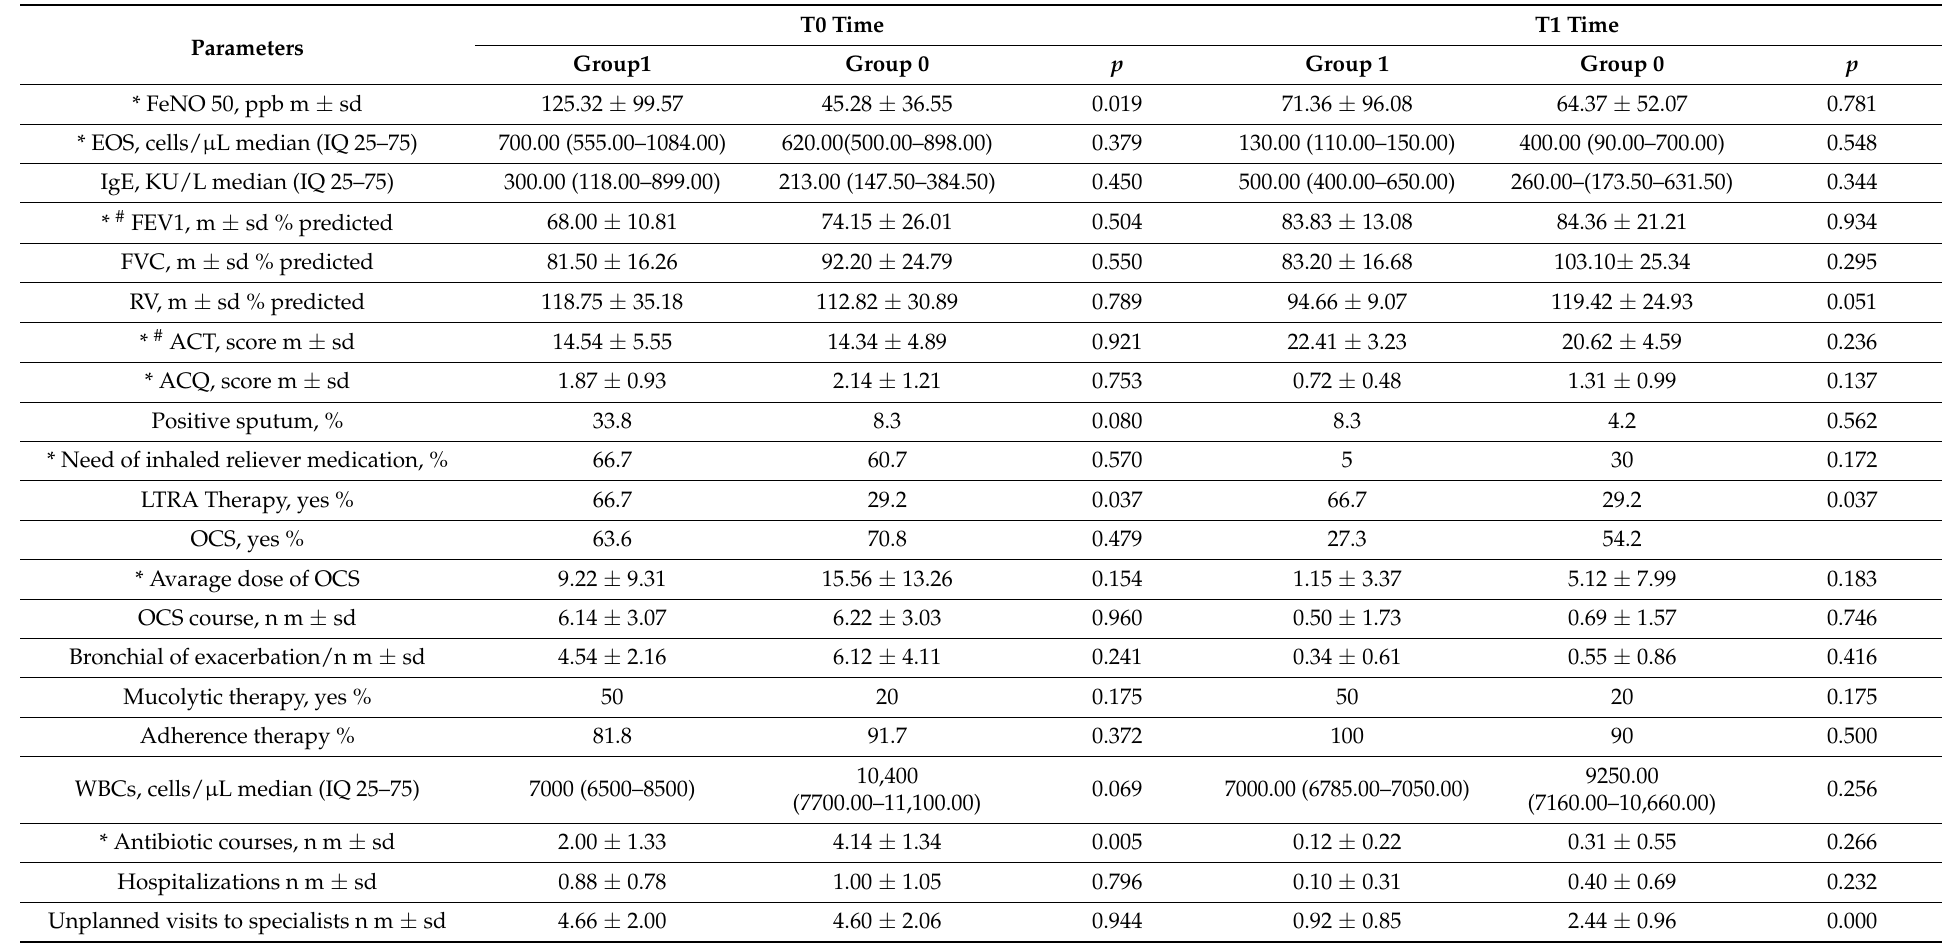
Table 4. Comparison between Groups 1 and 0, respectively, at times T0 and